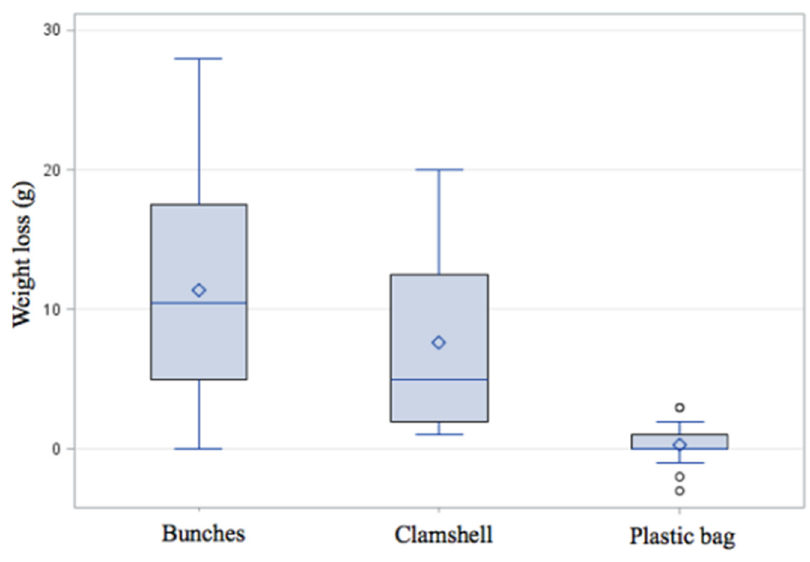
Figure 9. Weight loss in amaranth stored in bunches (control), clamshells and plastic bags during six hours storage at ambient